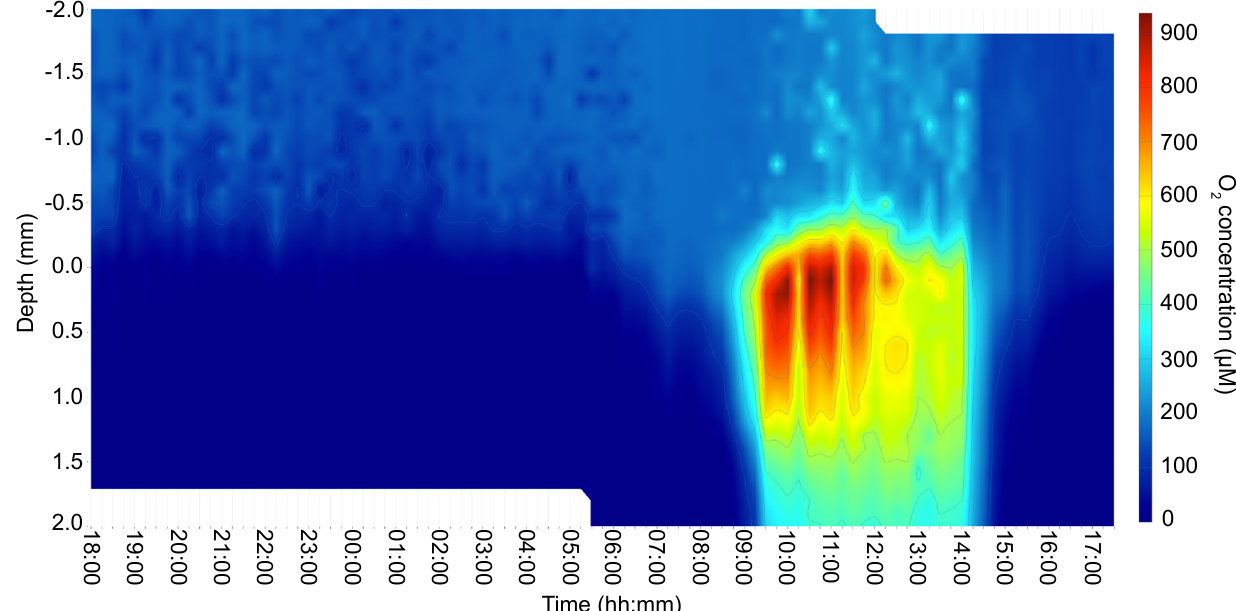
Figure 1. Photographs of the sampling site and cyanobacteria-dominated microbial mat. ( a ) The dark blue-green micro- bial mats developed at the “Stream Site” of Nakabusa Hot Springs, Japan [19]. ( b ) The microbial mat core samples col- lected at each time point were 8 mm in diameter and approx. 15 mm thick. The upper 3 mm of the core samples was used in this study.